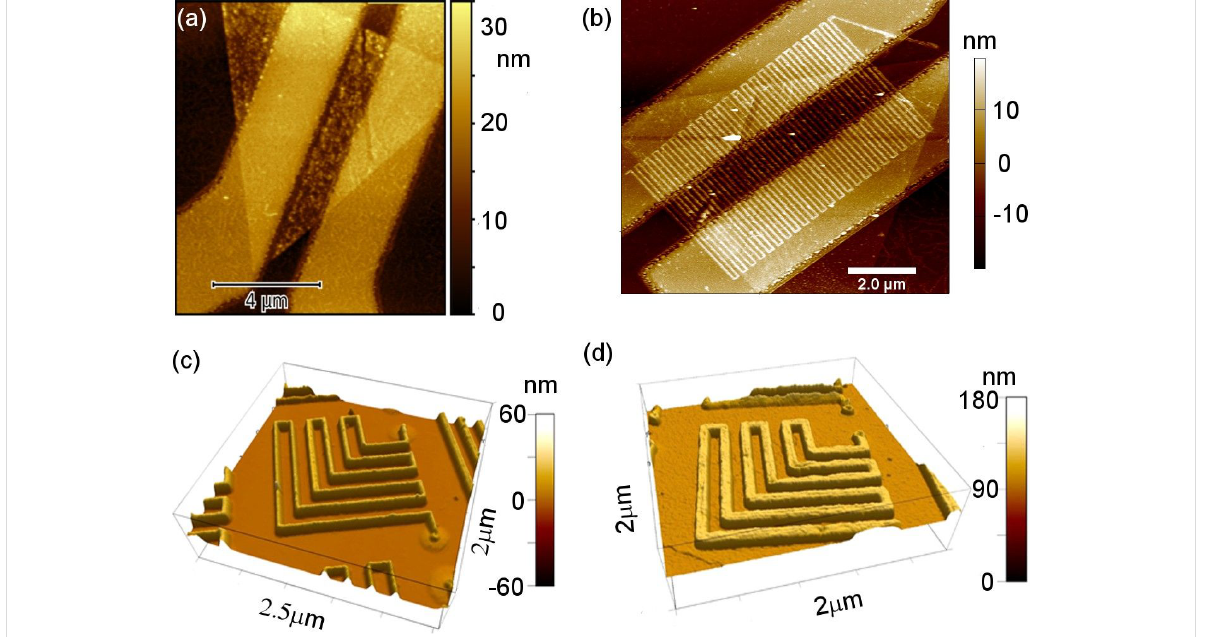
Figure 19: AFM images of FE-eSPL patterning of different materials. (a) MoS 2 -flake on SiO 2 substrate placed between gold contacts before pattern- ing. (b) MoS 2 flake after FE-eSPL patterning and first development step. (c) Patterning demonstration of novel molecular glass resist UBT7 from University of Bayreuth. (d) Patterning demonstration of HM01 fullerene resist from Irresistible Materials